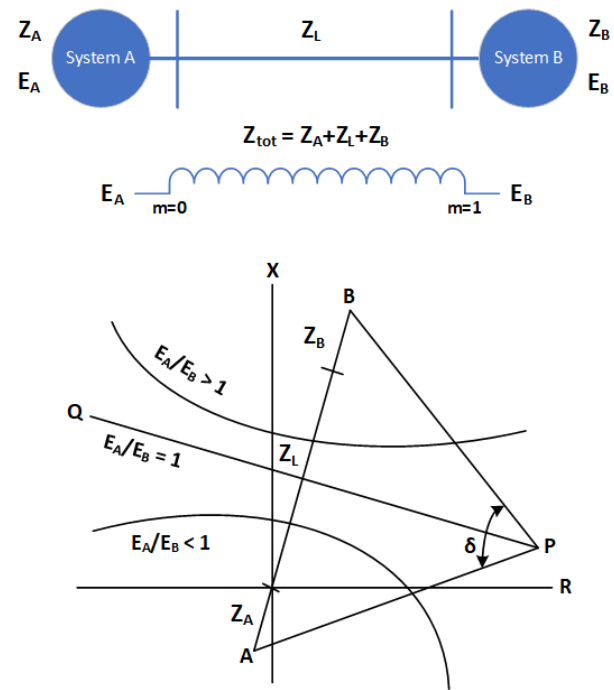
Figure 9. Impedance characteristic of the simple power system model.